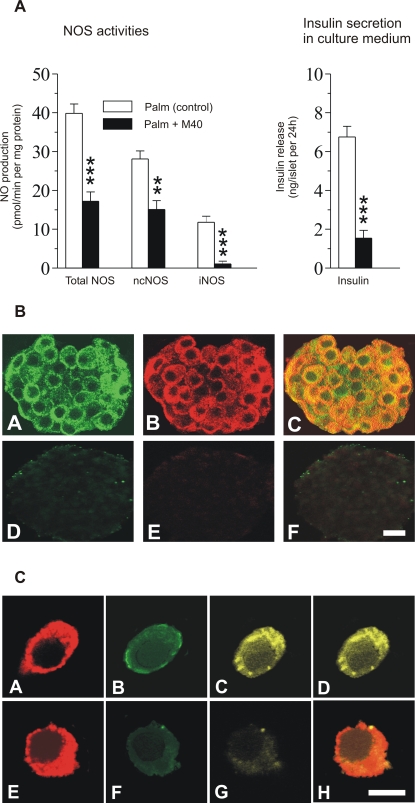
Islet NOS activities, insulin secretion, and expression of GPR40 and iNOS after treatment with palmitate and GPR40 antisense.Isolated islets were pretreated for 24 h with either the M40 antisense morpholino or a non-specific random sequence morpholino (control). The islets were incubated for 30 min in absence or presence of palmitate and then cultured with palmitate±M40 for a further 24 h. (A) M40 caused a marked suppression of palmitate-induced iNOS and ncNOS activities as well as a reduced insulin release (black bars). The results from the control morpholino are indicated by white bars. Values are mean±s.e.m for 4 different experiments performed at different occasions. ** p<0.01; *** p<0.001. (B) Expression of GPR40 (green) and iNOS (red) in islets cultured with palmitate (A-C) or palmitate+M40 (D-F). A and D = GPR40; B and E = iNOS, C and F = overlay. Bar indicates 5 μm. (C) Immunostaining and confocal images of formaldehyde-fixed β-cells. The expression pattern of insulin (red), GPR40 (green) and iNOS (yellow) from dispersed β-cells cultured with palmitate is shown. A = insulin, B = GPR40, C = iNOS and D = overlay. E–H show absence of expression of GPR40 (F) and iNOS (G) after M40 treatment. E = insulin, H = overlay. Bar indicates 5 μm.